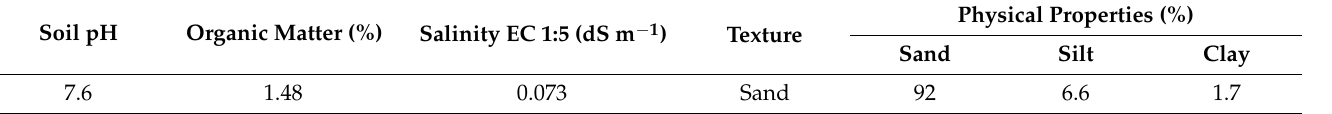
Table 2. Soil analysis data of the trial